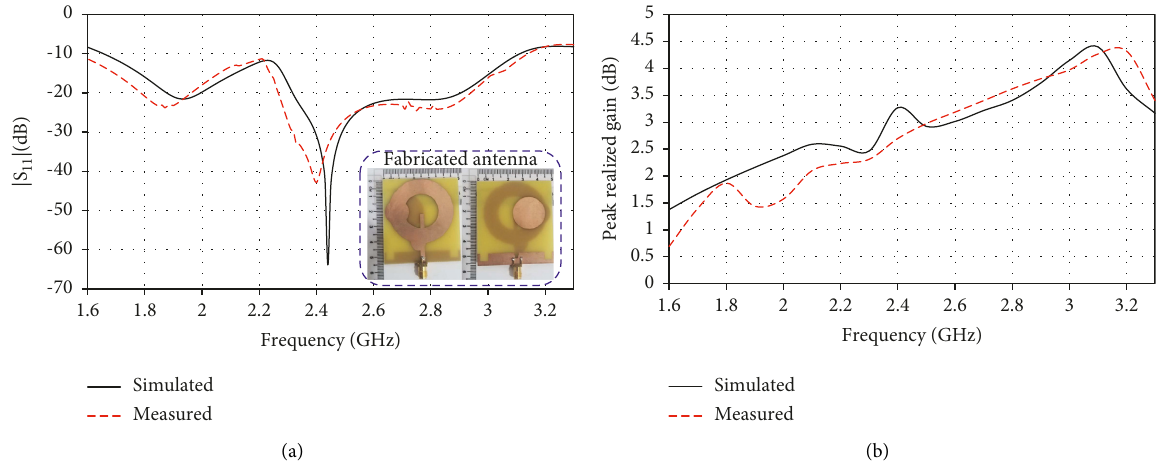
Figure 6: Simulated and measured (a) reflection coefficient (|( S ) antenna against